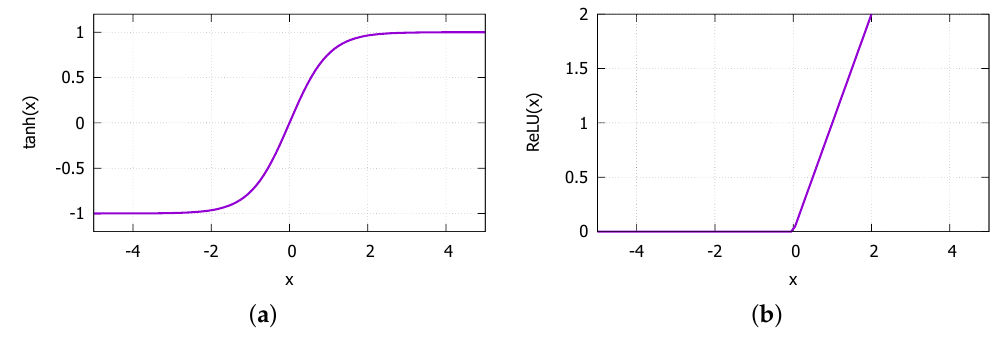
Figure 11. Activation functions: ( a ) hypertangent (tanh) used for hidden layers; ( b ) rectified Linear Unit (ReLU) activation function used for the output